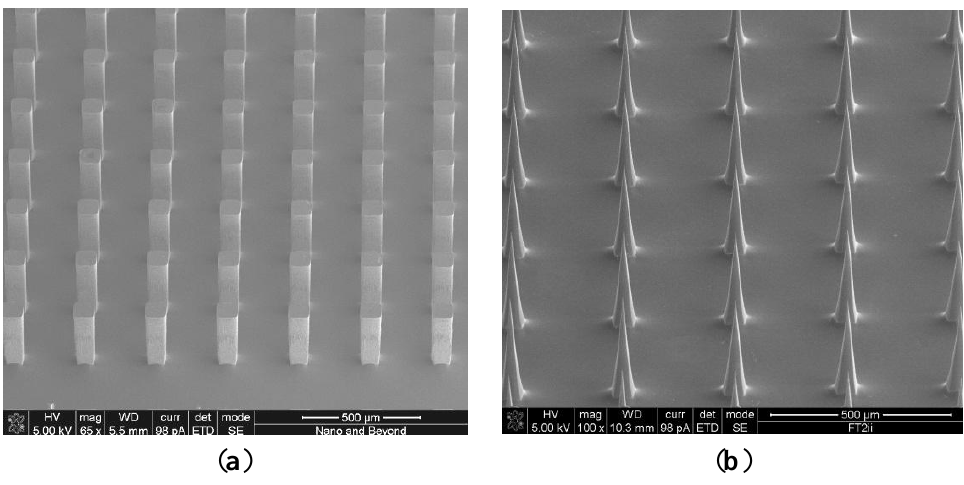
Figure 2. SEM images of ( a ) the 15 × 15 Si pillar array after DRIE; and ( b ) Si microneedle array after wet etch process. The scale bar shows 500 µm.